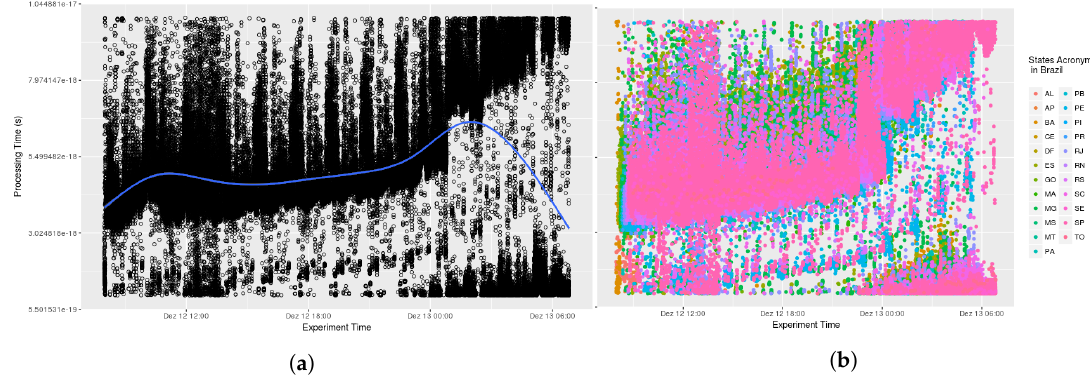
Figure 10. Scenario 02—Processing Time. ( a ) Stations in the whole country of Brazil; ( b ) Stations grouped by states.